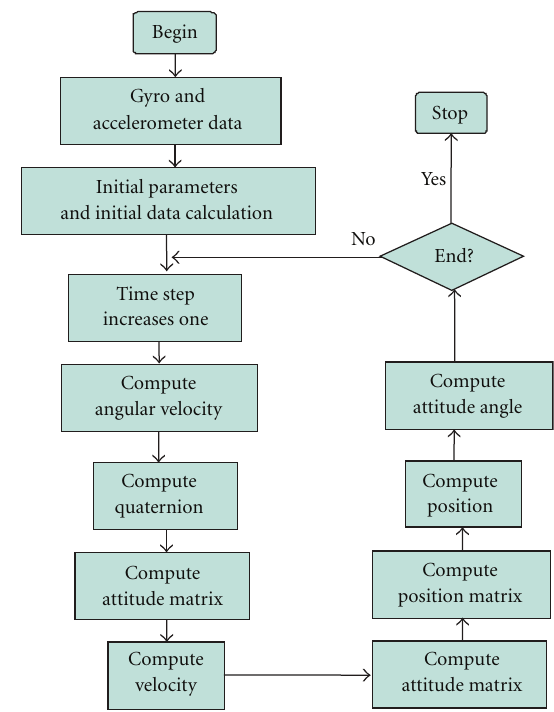
Figure 8: SINS program